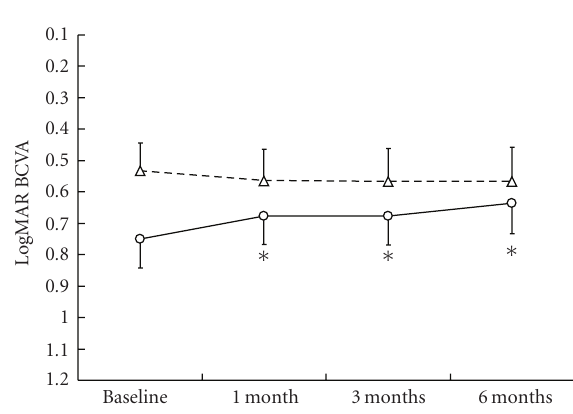
Figure 3: Time-course of the foveal thickness with oral bisphos- phonates. Solid line; AMD, dashed line; myopic CNV. The values are presented as means + SEM. ∗ P < . 05, ∗∗ P < . 01.